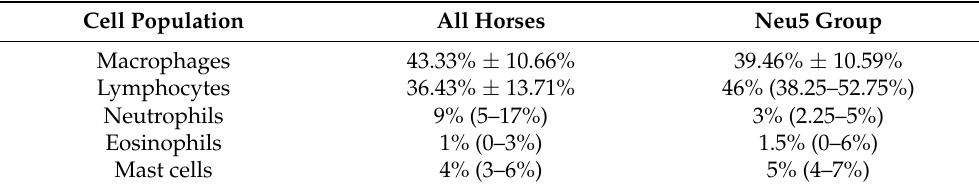
Table 1. Leukocyte differential counts of the bronchoalveolar lavage fluids of all horses and those included in the Neu5 Group. Data are expressed as mean ± standard deviation if normally distributed, or median (IQR) if not normally distributed. Cell